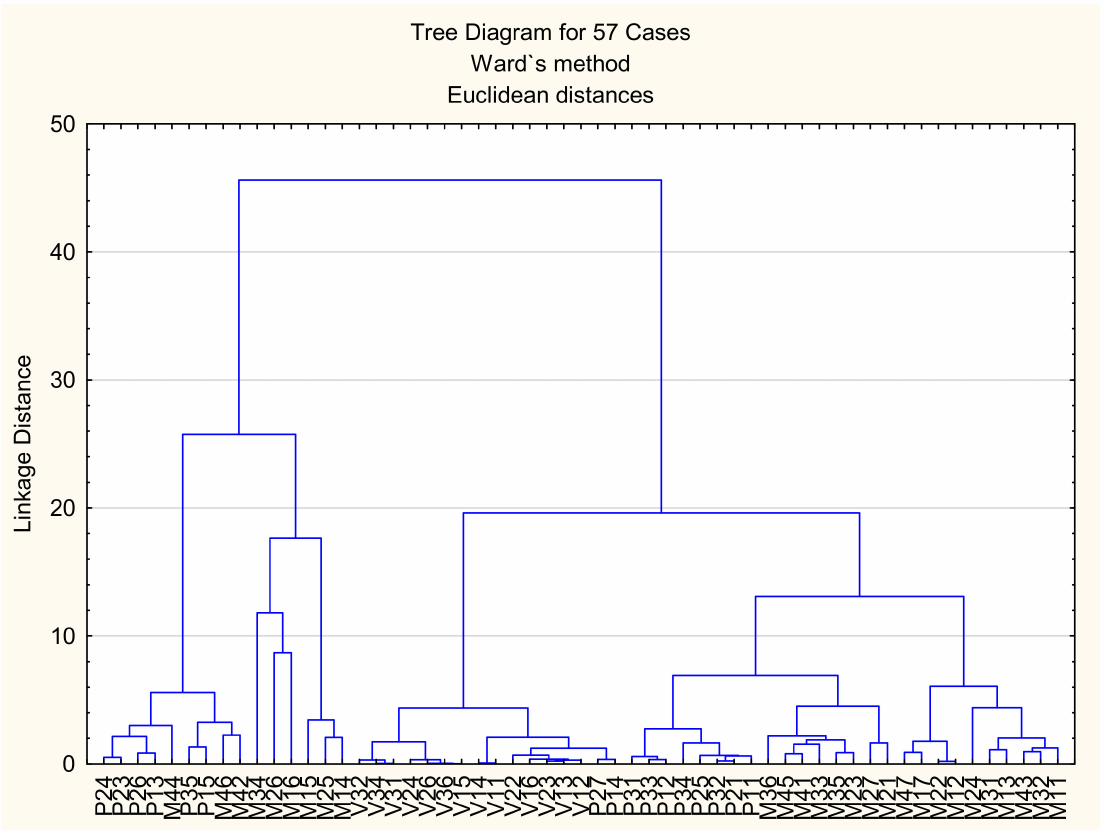
Figure 10. The dendrogram of the clustering of the examined types of marine environments based on the results of the EDX